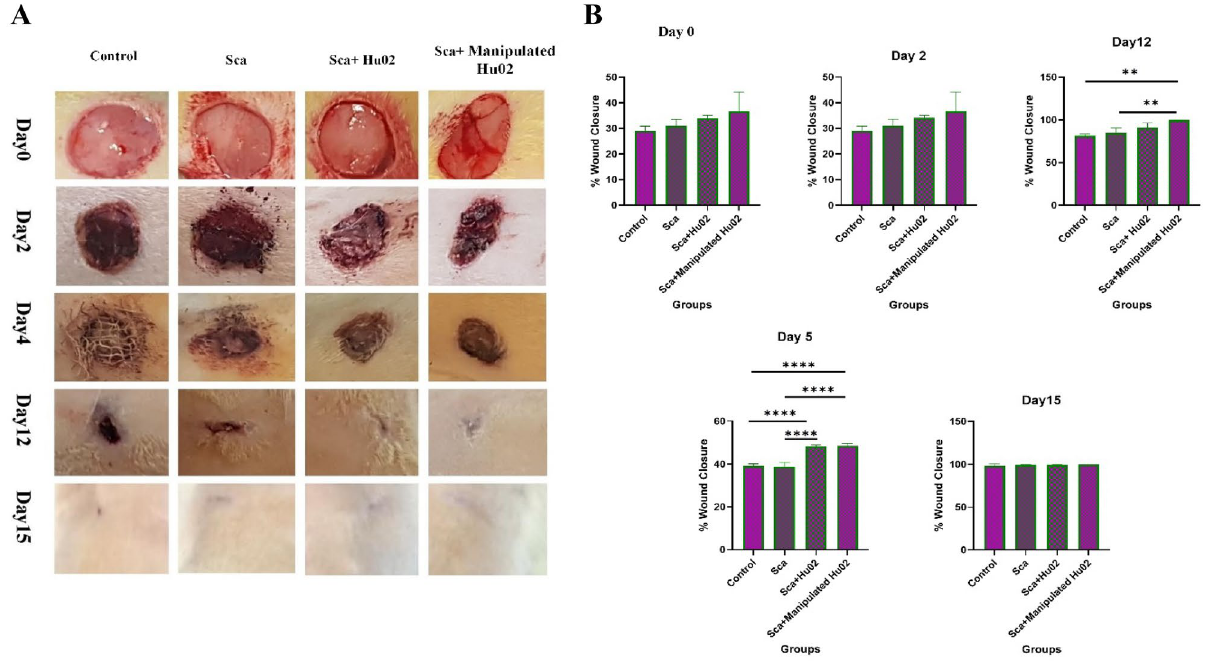
Sca + Manipulated Hu02). ( B ) The level of wound closure progression as a percentage of the remaining wound area at definite time points. (** p < 0.01, **** p <